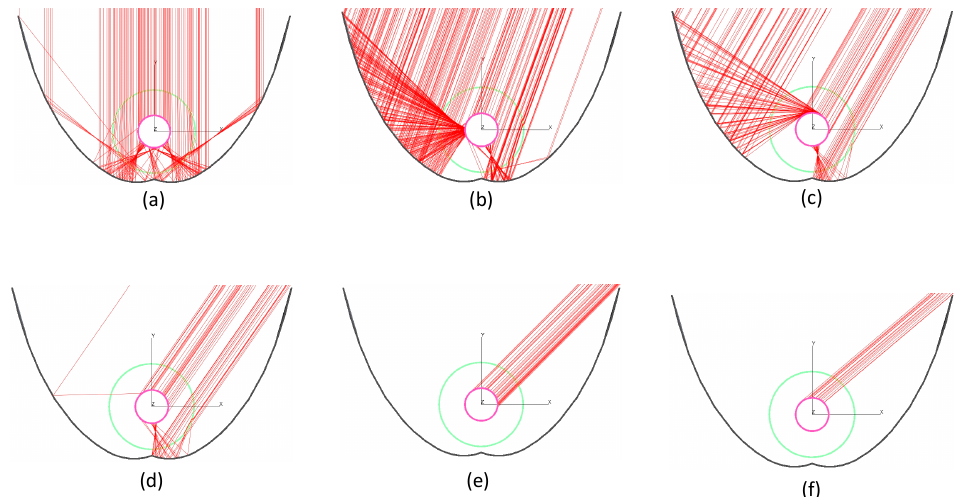
Figure 8. Ray path diagrams of absorbed radiation in case of 60% truncated CPC with SFT receiver for different incidence angle: ( a ) 0°; ( b ) 20°; ( c ) 30°; ( d ) 35°; ( e ) 45°; ( f ) 50°.